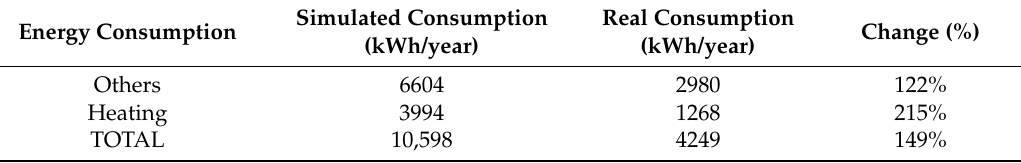
Table 8. Comparison of simulated and actual consumption in a dwelling of building B, in kWh/year.